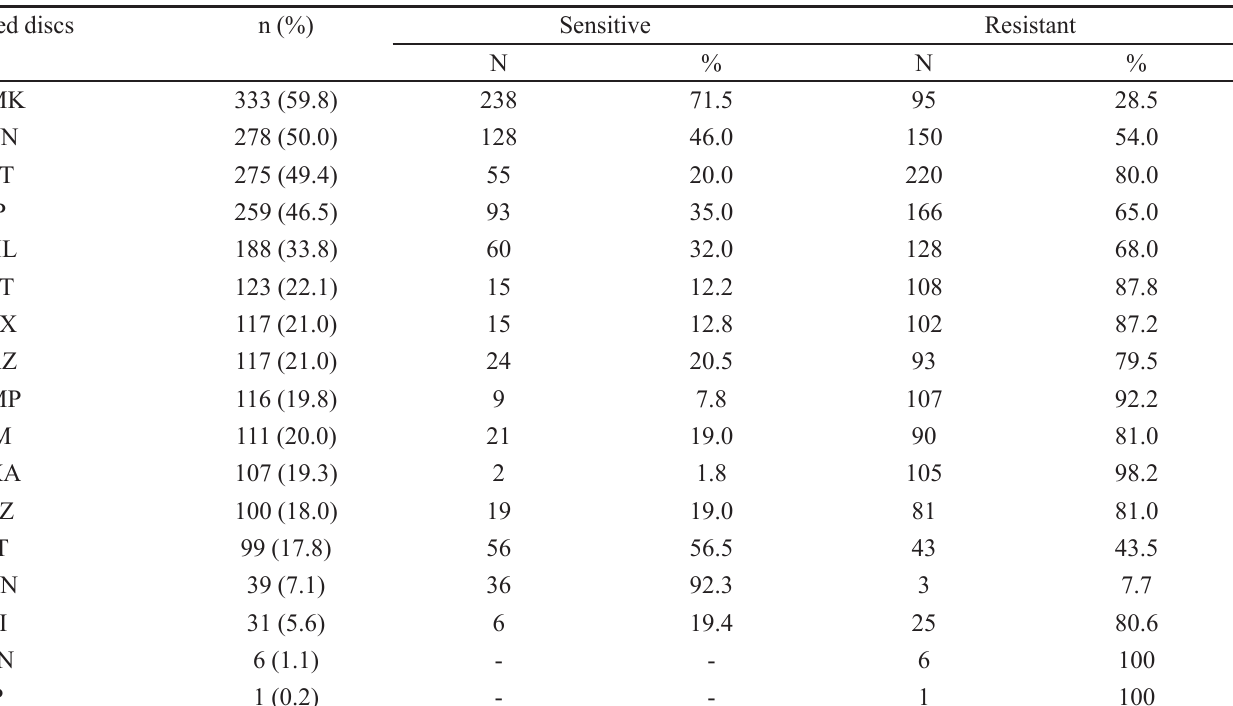
TABLE IV - Overall susceptibility rates of the microorganisms isolated from the ICUs Used